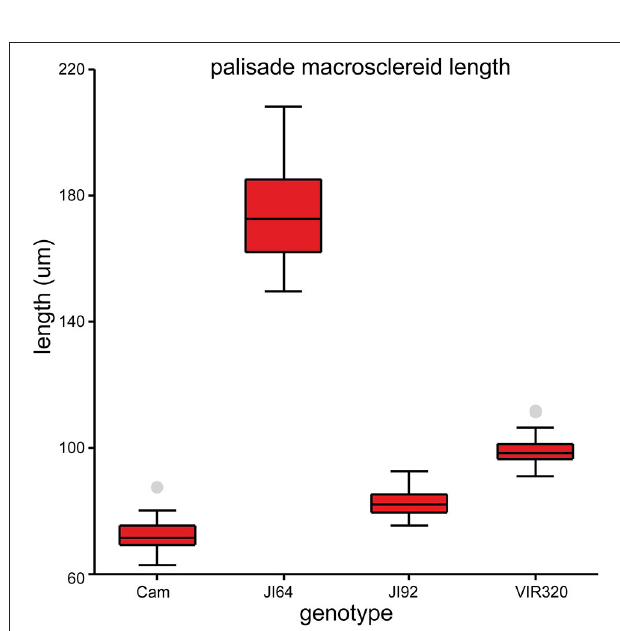
of significant amount of lignins in the testa of analyzed pea